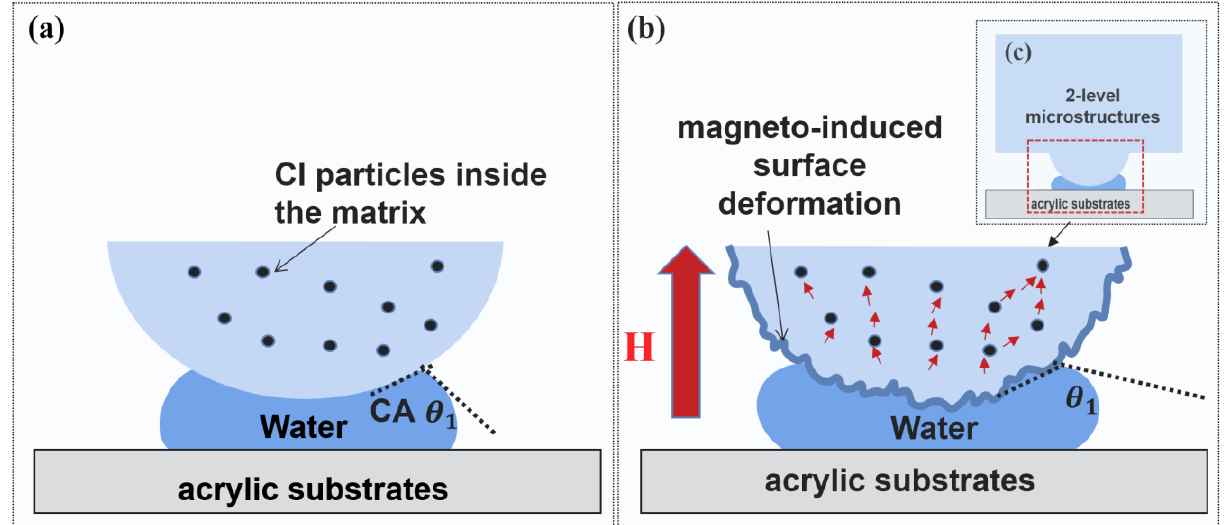
Figure 8. The mechanism of the magneto-responsive adhesion of 2L-MAE detached from wet acrylic substrates. ( a ) the pull-off process without magnetic field in microscopic ( b ) the pull-off process with magnetic field in microscopic ( c ) the pull-off process with magnetic field in mesoscopic.